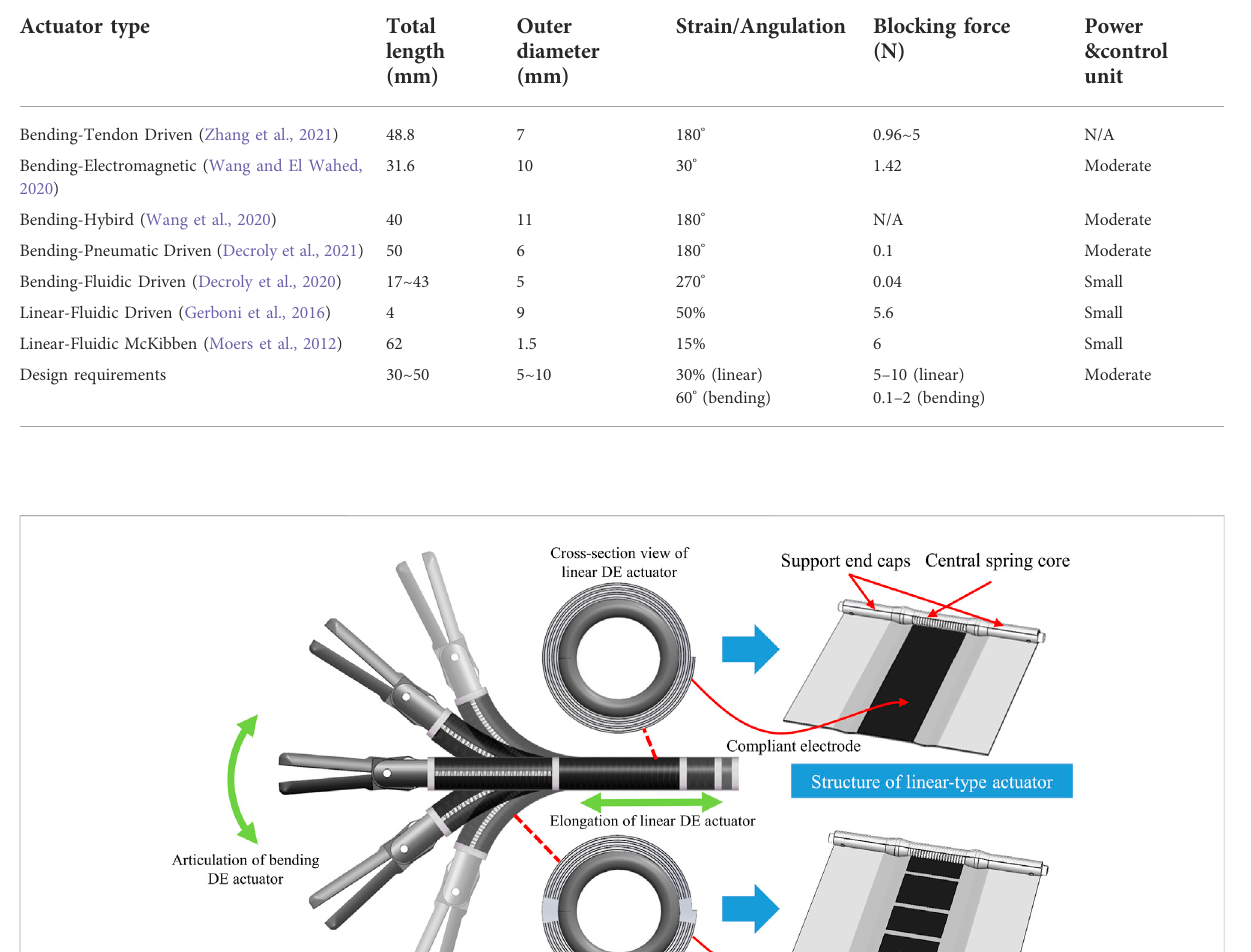
TABLE 1 Performance of different actuators and design requirements of DE actuators proposed for MIS applications.